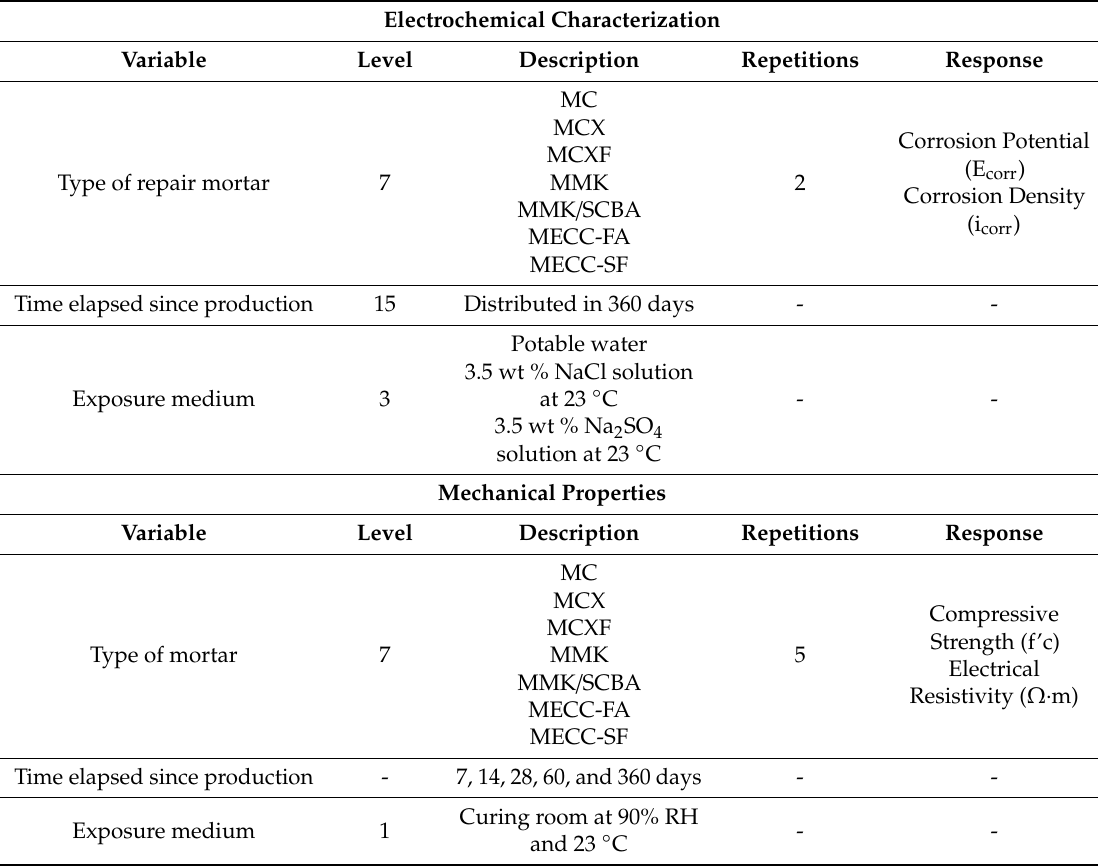
Table 6. Variables tested in this